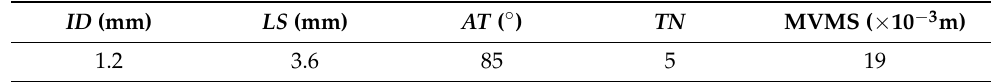
Table 6. Design factors and MVMS for